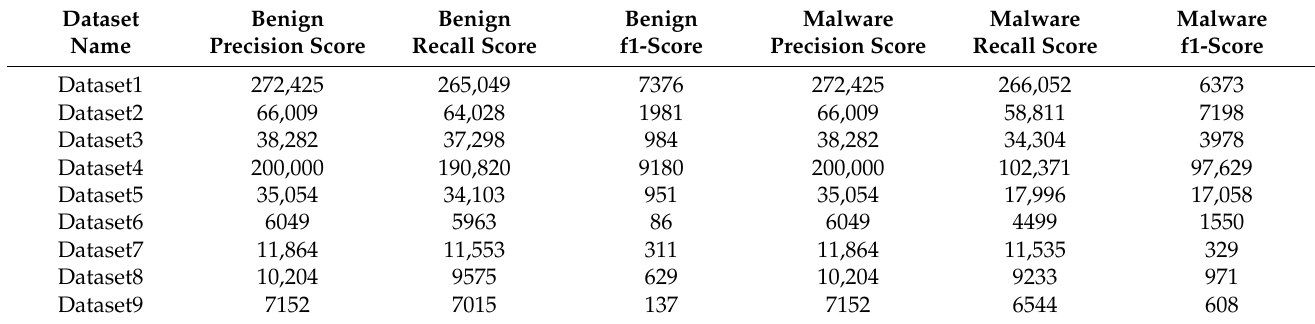
Table 11. Confusion matrix for testing the DL algorithm with minimum features.